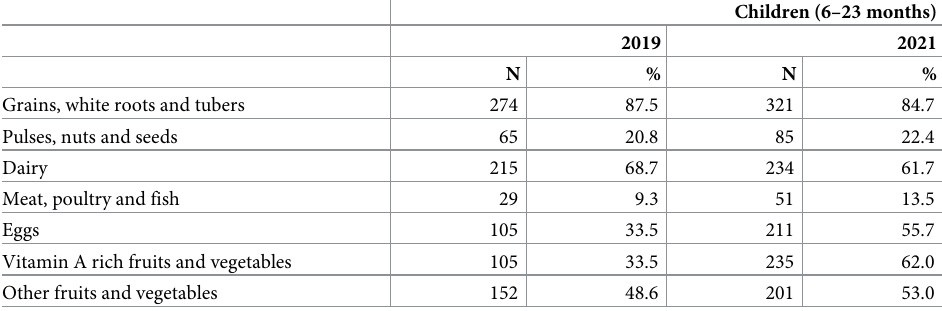
Table 1. Dietary intake from food groups among children (6–23 months), Gadchiroli and Chandrapur, 2019 and 2021.